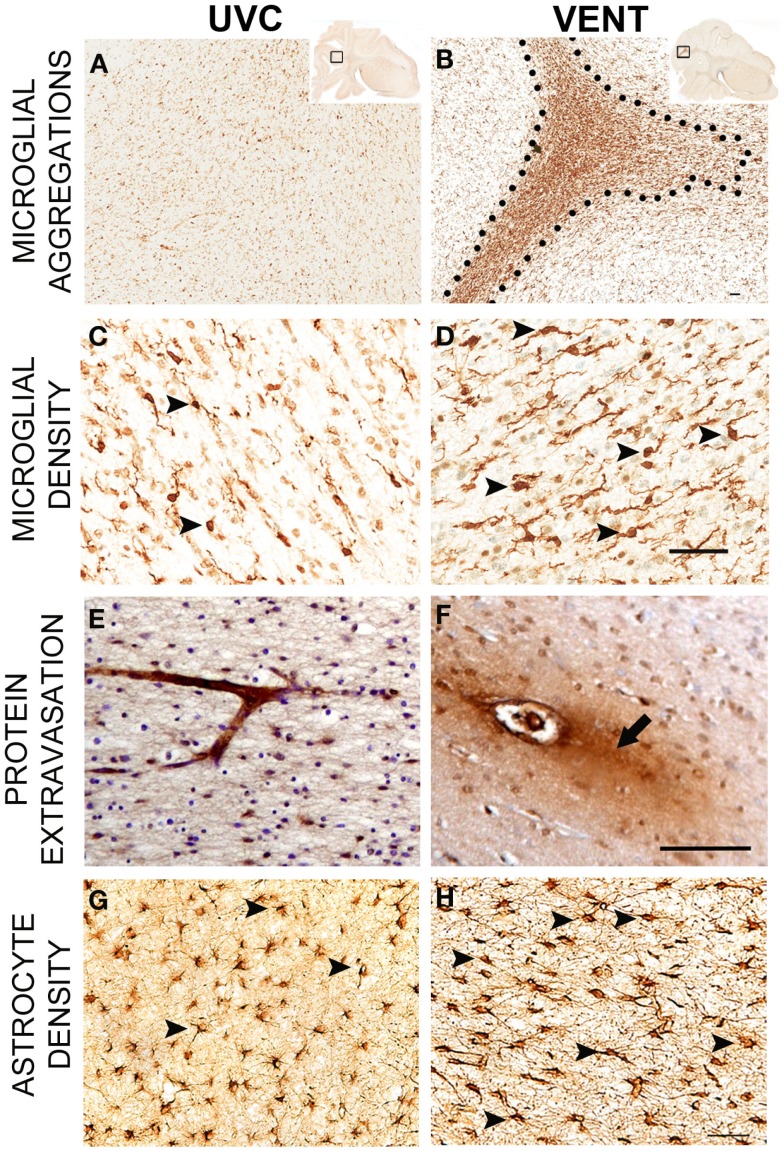
Pathology of ventilation-induced brain inflammation and injury. Comparative immunohistological findings from the subcortical white matter of the parietal lobe from an unventilated control lamb (UVC; left panel) and a lamb ventilated with a high V
T (Vent; right panel). Lambs ventilated with a high V
T have larger, denser microglial aggregations (A,B), increased microglial density [(C,D); arrowheads indicate Iba-1 positive microglia], increased blood–brain barrier permeability evidenced by protein extravasation [(E,F); arrow indicates protein extravasation from the vessel labeled with an anti-sheep serum antibody] as well as increased astrogliosis [(G,H); arrowheads indicate GFAP-positive astrocytes]. Scale bar represents 50 μm. Images adapted from Ref. (73, 76).